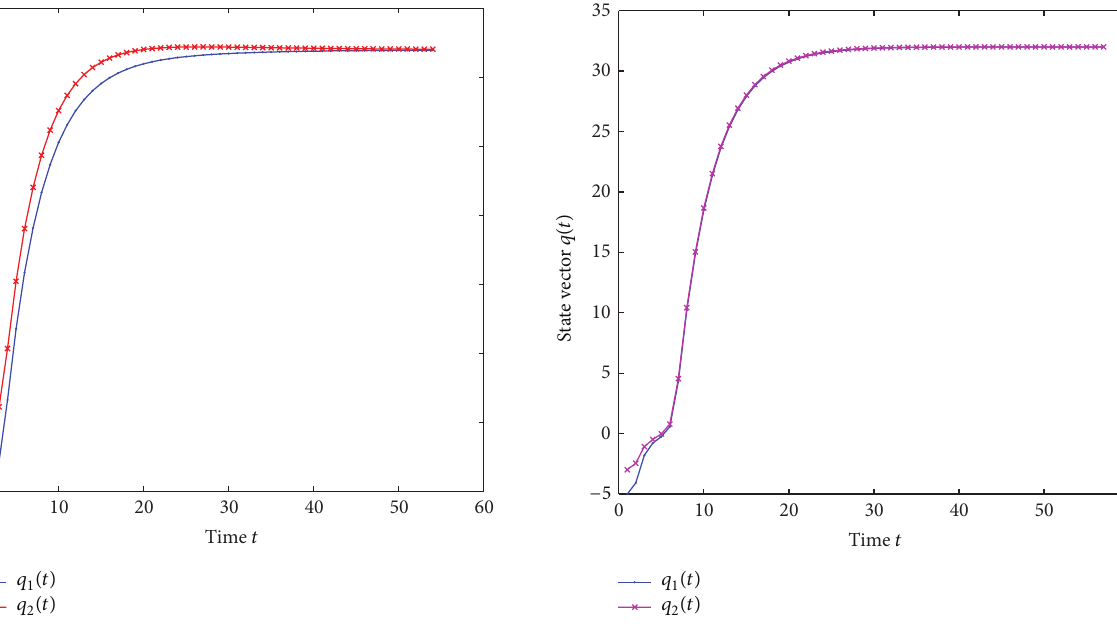
see that the state vector of neural network approximately exponentially converges to the Nash equilibrium